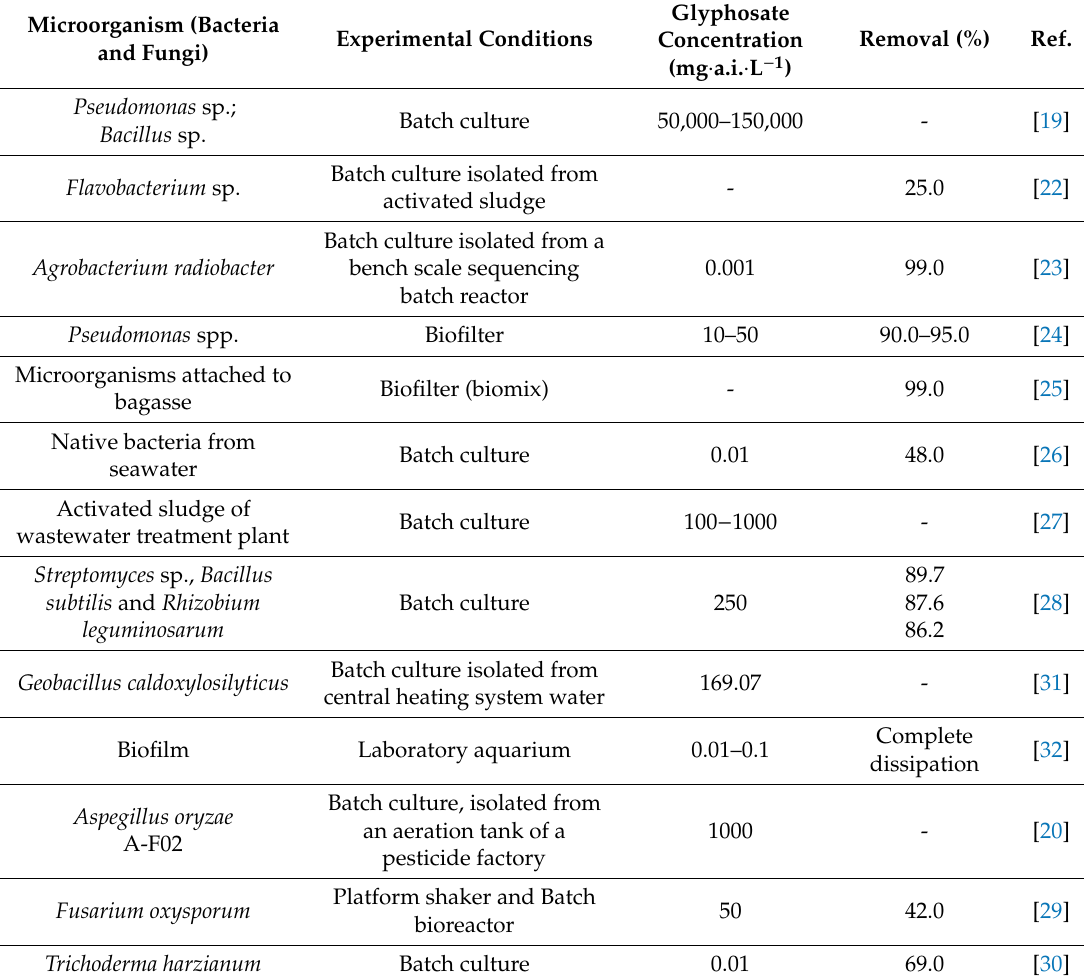
Table 1. Removal of glyphosate from water polluted by biological